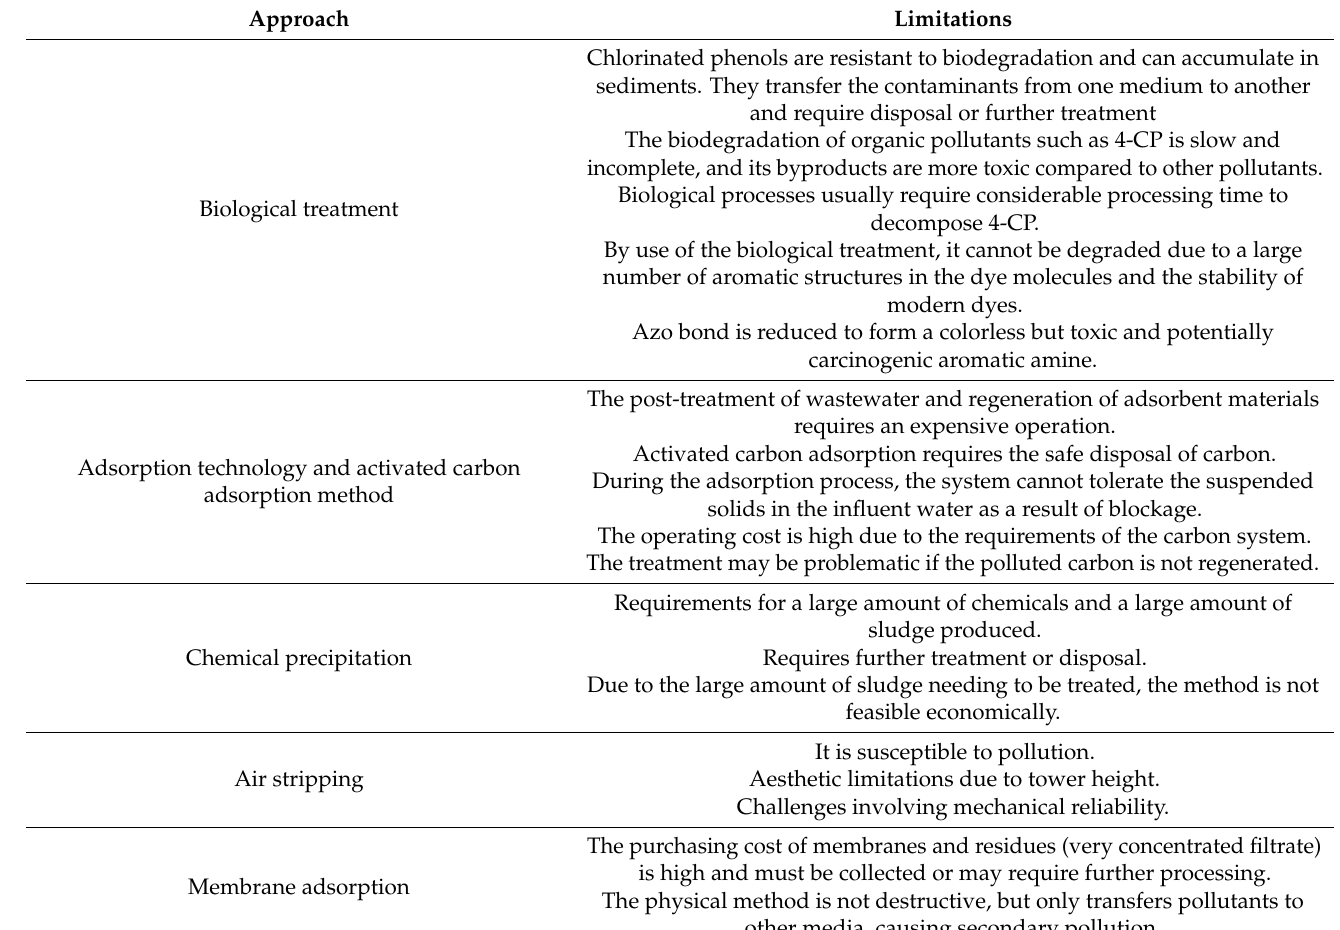
Table 1. Traditional photodegradation methods and